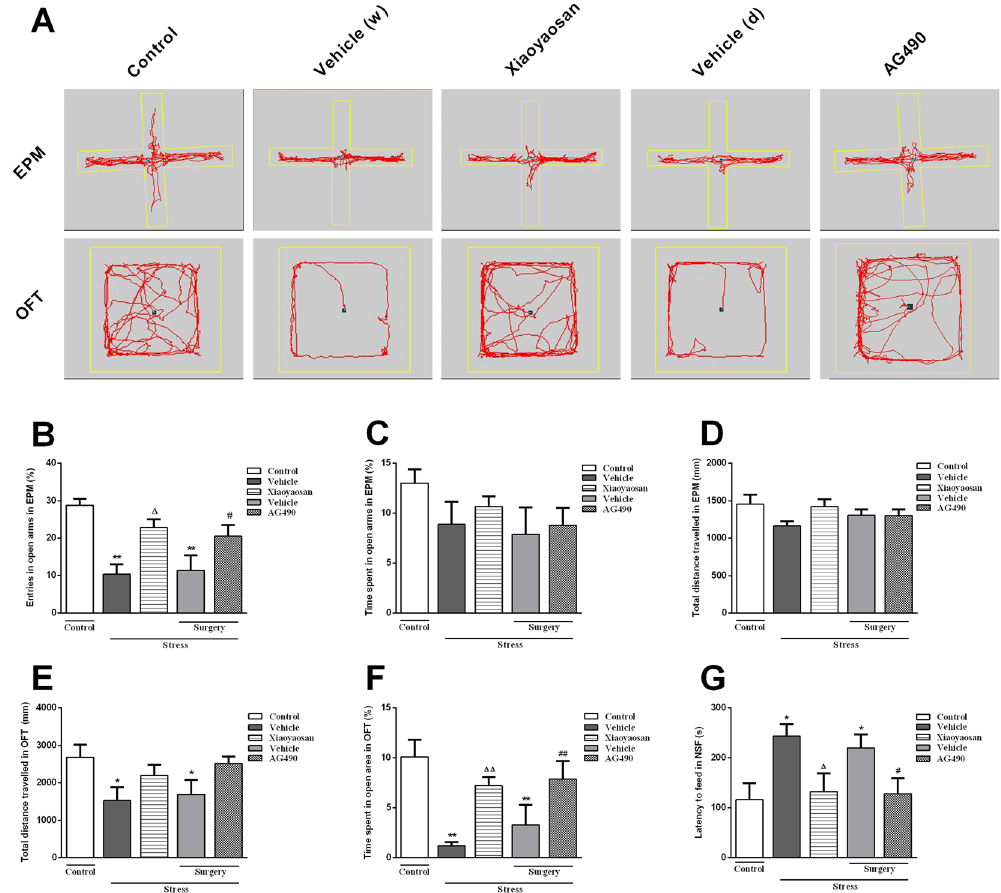
Figure 1. Effects of Xiaoyaosan on anxiety-like behaviours. The EPM test, OFT, and NSF test were conducted at the end of the experiment. The percentage of entries and time spent in the open arms and the total distance travelled in the EPM were measured. The total distance travelled and percentage of time spent in open area of the OFT were determined. The latency of the rats to feed within 5 min in the NSF test were recorded. ( A ) The track maps of the rats in the different groups in the EPM test and OFT. ( B ) Percentage of entries in open arms of the EPM. ( C ) Percentage of time spent in the open arms of the EPM. ( D ) Total distance travelled in the EPM. ( E ) Total distance travelled in the OFT. ( F ) Percentage of time spent in the open area of the OFT. ( G ) Latency to feed in the NSF test. Values are presented as the means ± SEM with 9–10 rats in each group. * P < 0.05 or ** P < 0.01 versus the control group. Δ P < 0.05 or ΔΔ P < 0.01 versus the vehicle (distilled water) group. # P < 0.05 or ## P < 0.01 versus the vehicle (dissolvent)